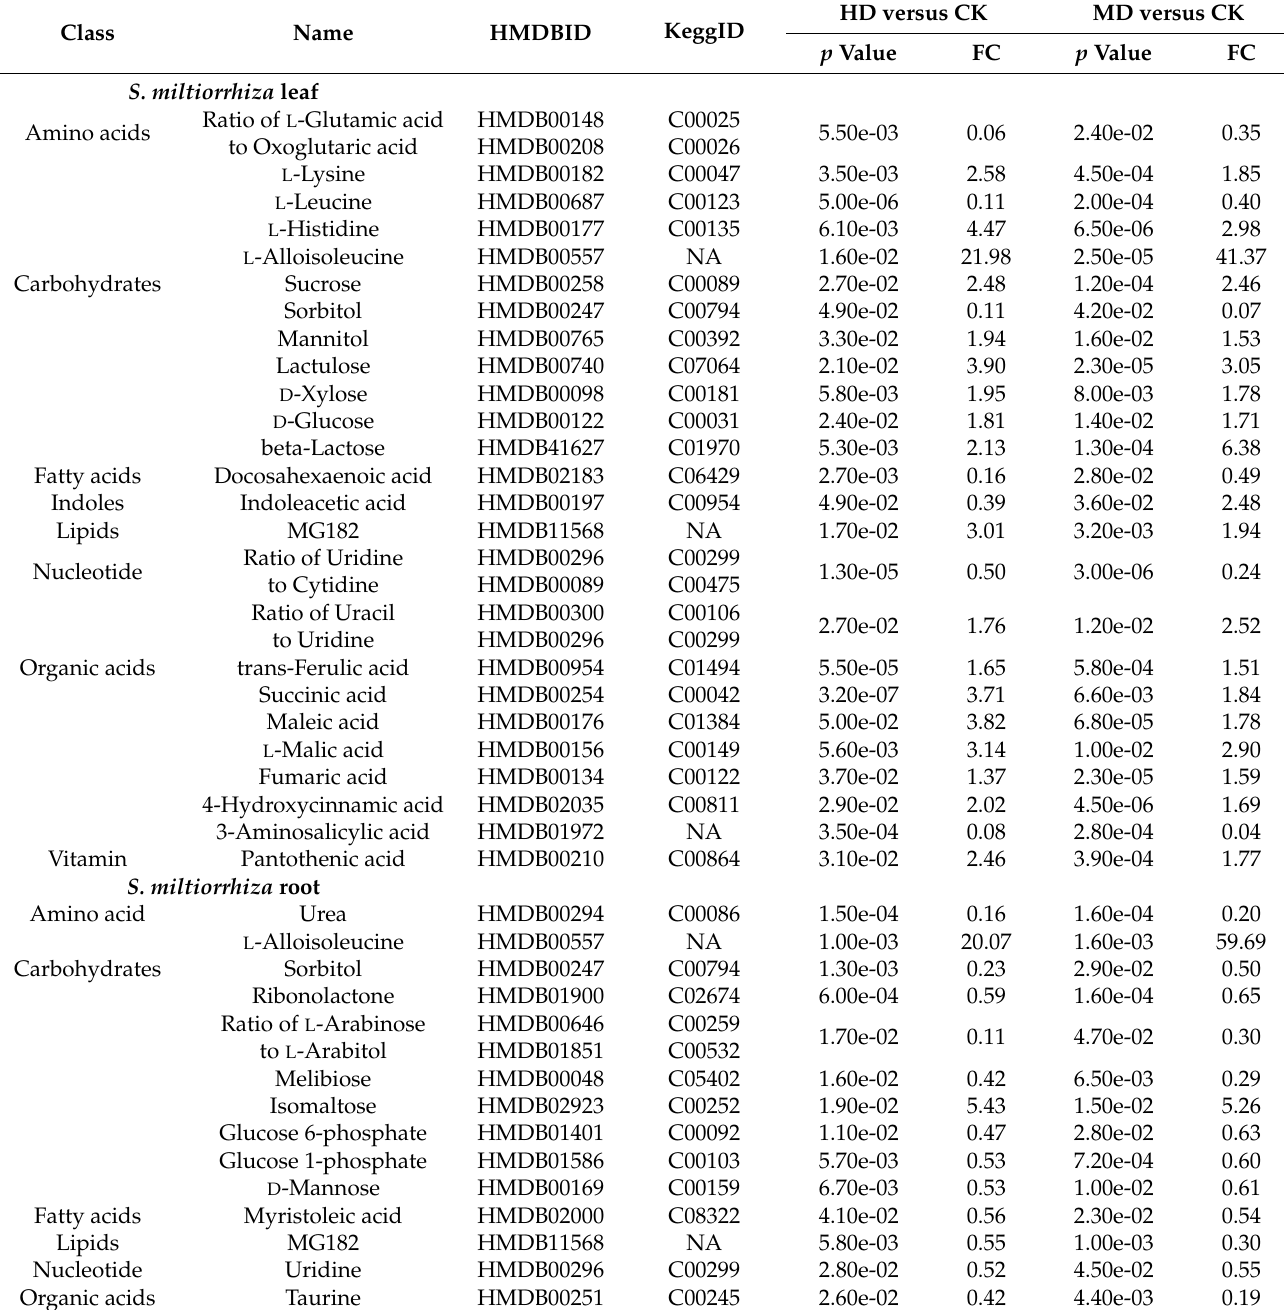
Table 1. Significantly differential metabolites in Salvia miltiorrhiza Bunge leaf and root induced by drought stress by univariate